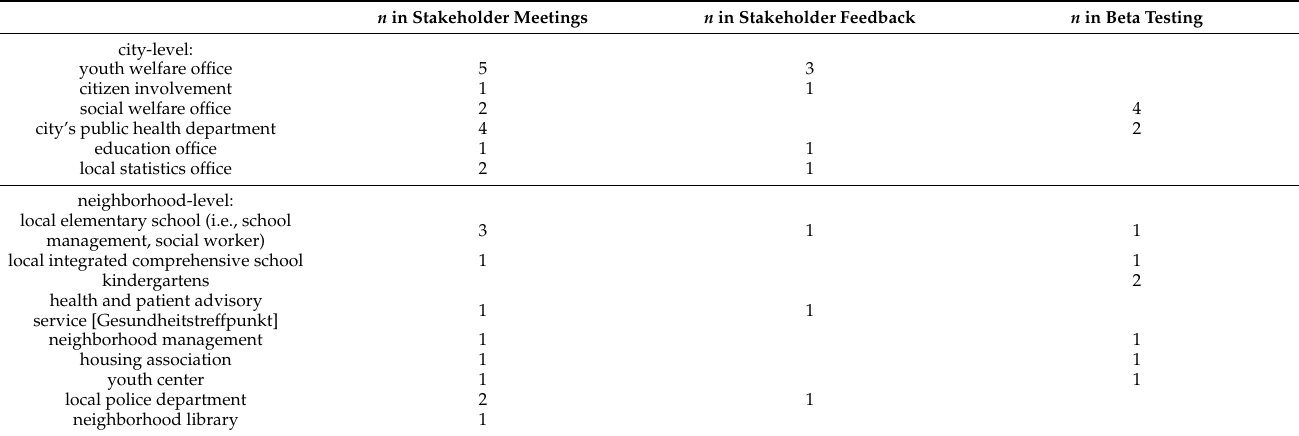
Table 1. Numbers of stakeholders involved by affiliation for each feedback